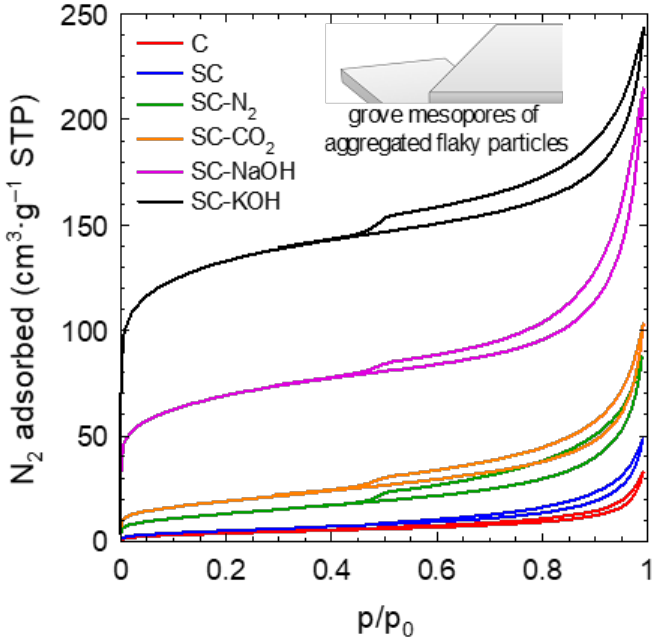
Figure 1. N 2 adsorption–desorption isotherms of the char from plastic pyrolysis before and after activation.